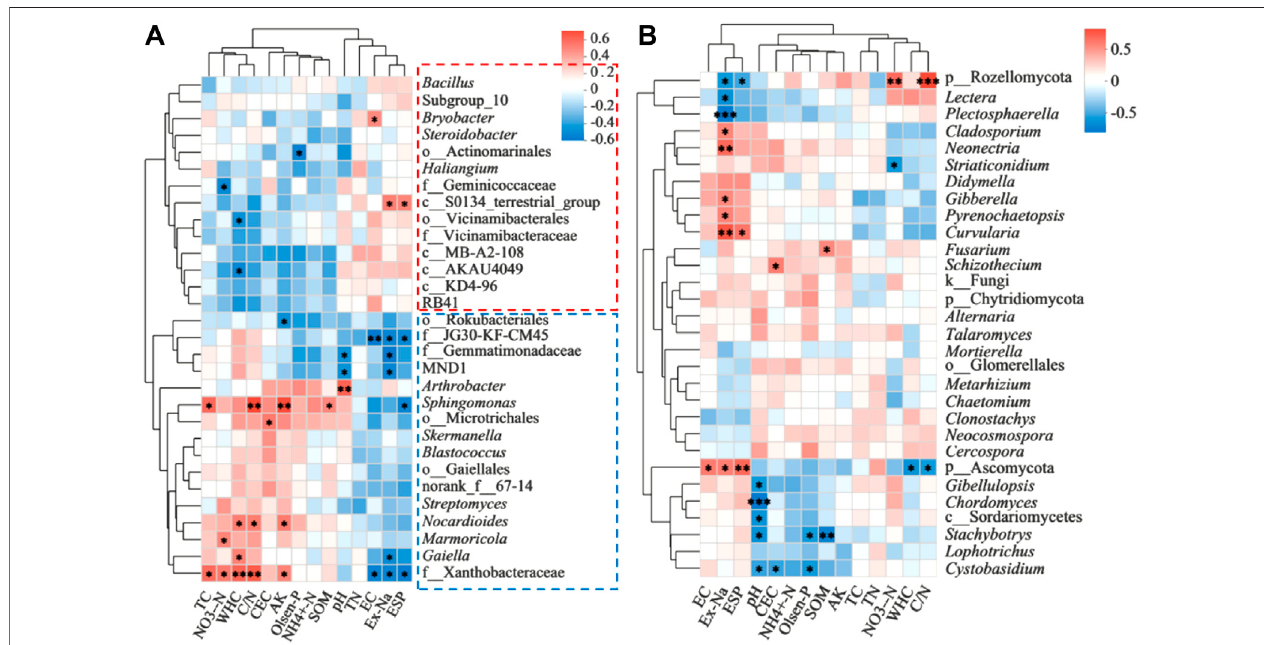
FIGURE6| Spearmancorrelationheatmapsrevealingthecorrelationsofsoilphysicochemicalpropertiesandtherelativeabundancesoftop30dominantgeneraof bacteria (A) and fungi (B) . *0.01 ≤ p < 0.05, **0.001 ≤ p < 0.01, *** p <